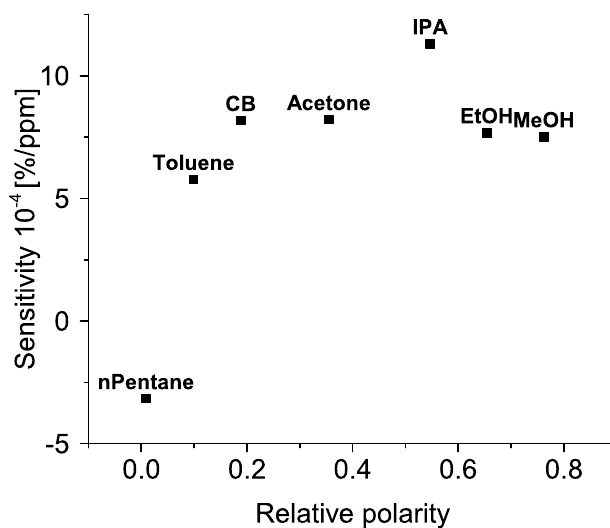
Figure 9. Sensitivity of an oxidized sample in dependence on relative polarity of organic molecules. CB, IPA, EtOH, and MeOH stand for chlorobenzene, isopropanol, ethanol, and methanol, respectively. See Section 4 for